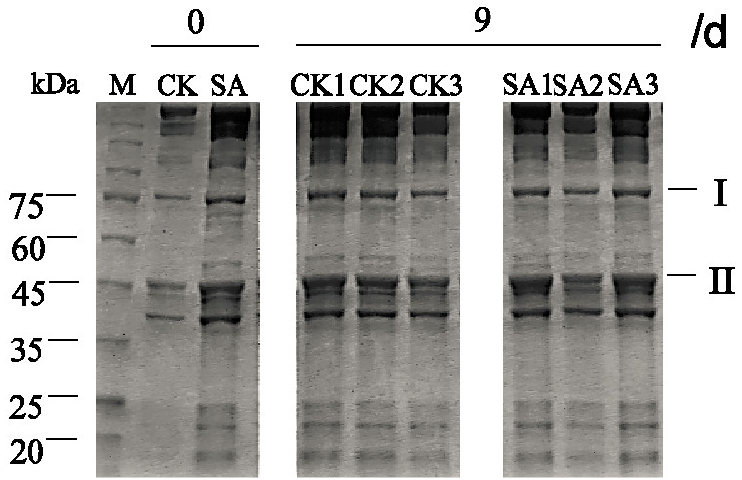
Figure 6. Effect of cell-free culture supernatant (CFS) from A. sobria on the sodium dodecyl sulfate-polyacrylamide gel electrophoresis (SDS-PAGE) profile of the myofibrillar proteins of Pacific white shrimp ( L. vannamei ) during different cold chain logistics.